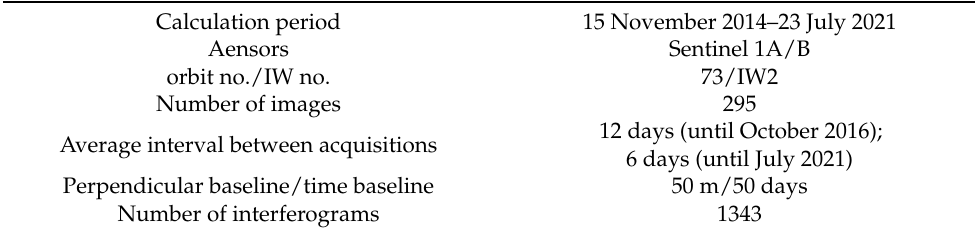
Table 1. Basic information of SAR data and SBAS results used in forecasting.